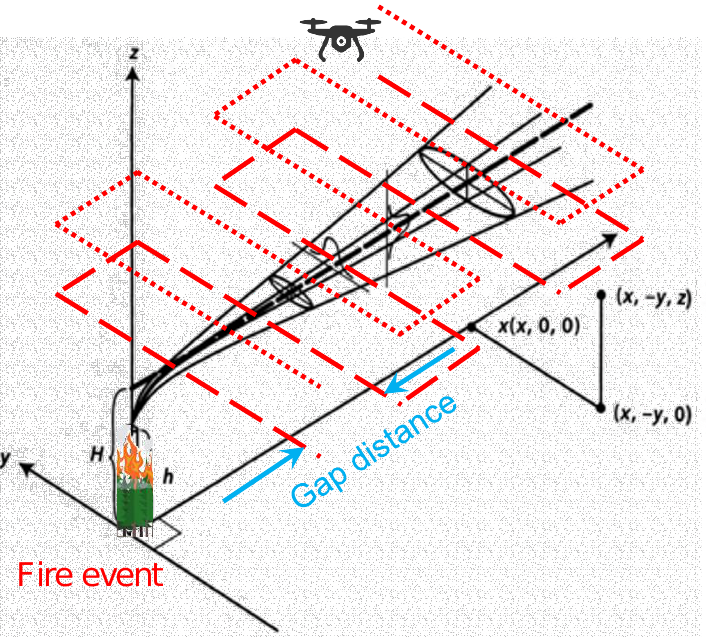
Figure 2. A Gaussian dispersion model for estimating the levels of air